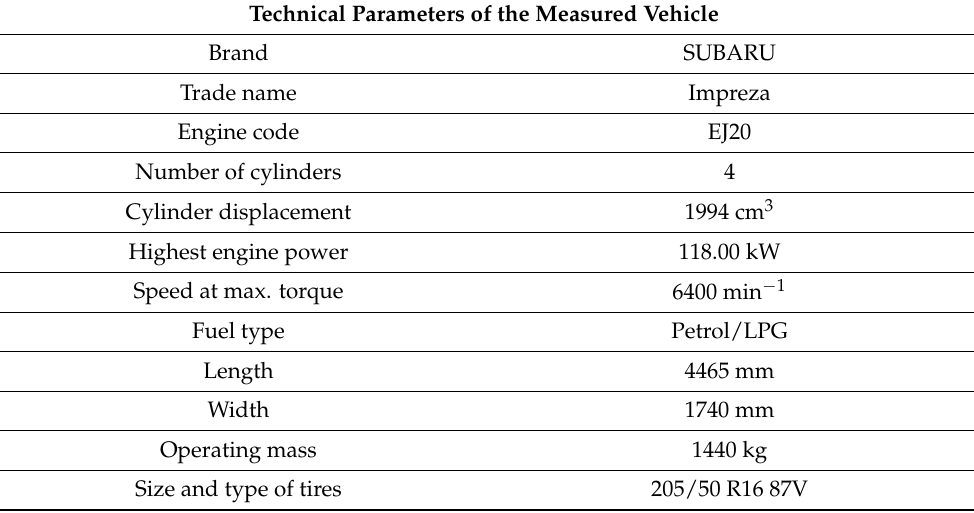
Table 3. Technical parameters of the measured vehicle [certificate of